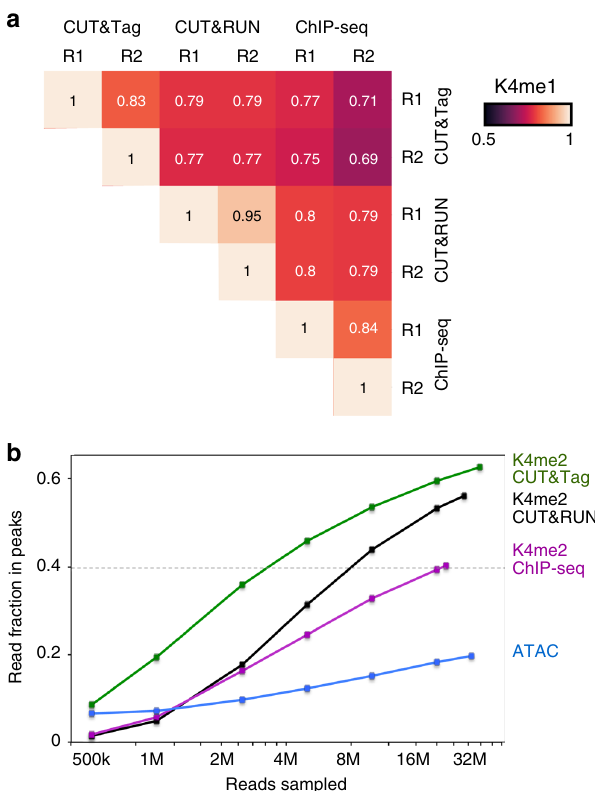
Fig. 3 Reproducibility and ef fi ciency of CUT&Tag. a Hierarchically clustered correlation matrix of CUT&Tag replicates (R1 and R2) and with CUT&RUN and ChIP-seq pro fi ling for the H3K4me1 histone modi fi cation. The same antibody was used in all experiments. Pearson correlations were calculated using the log 2 -transformed values of read counts split into 500 bp bins across the genome. b Ef fi ciency of peak-calling between methods. Mitochondrial reads were removed from datasets from each method pro fi ling the H3K4me2 histone modi fi cation. The remaining read counts were downsampled to varying depths, and then used to call peaks using MACS2. The summed number of reads falling within called peaks in each dataset was plotted. Source data are available in the Source Data fi